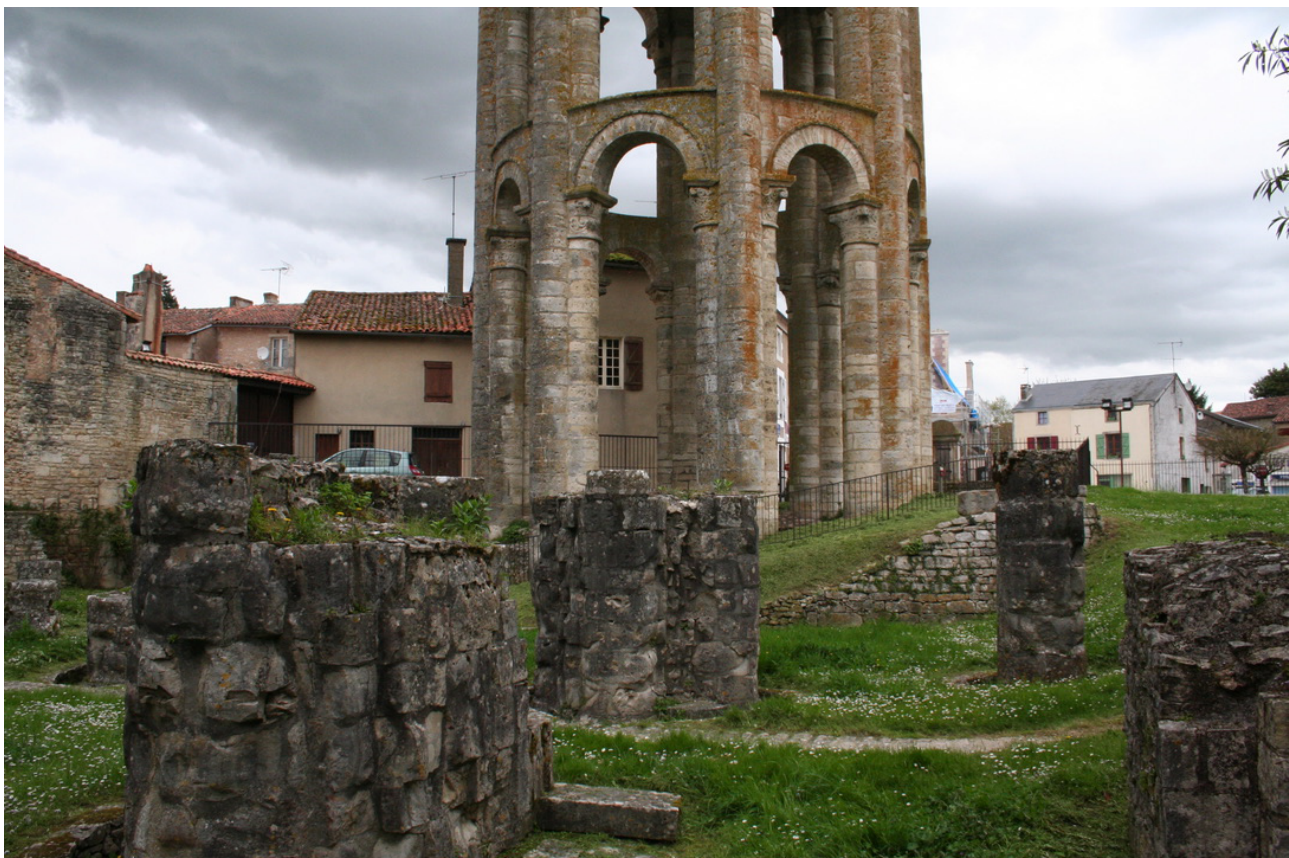
Figure 8. Abbey of Saint-Sauveur de Charroux, tower and piers belonging to the former choir rotunda, completed ca. 1096 (Photo: author).